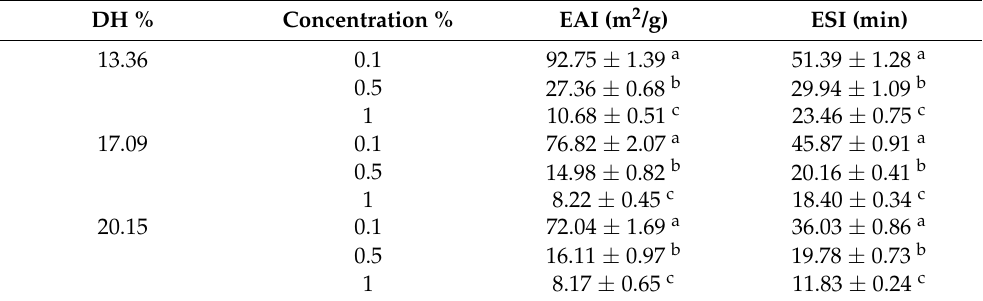
Table 4. Emulsifying characteristics of protein hydrolysate obtained from bighead carp using ficin enzyme with different hydrolysate concentrations at various DHs (mean ± SD, n =